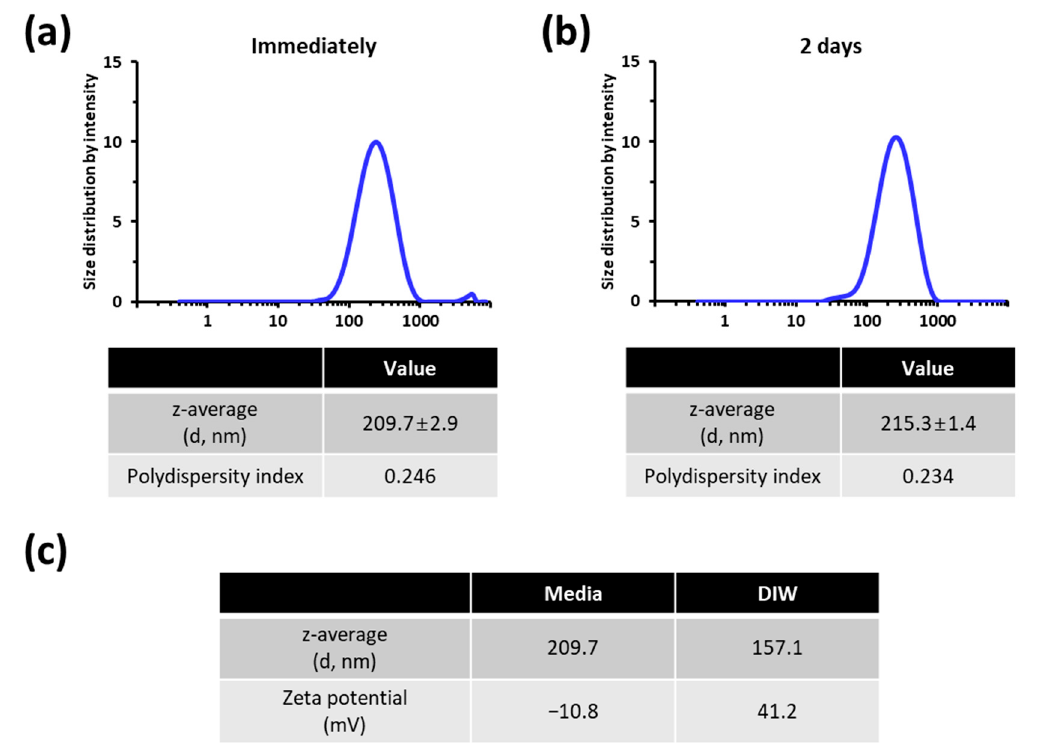
Figure 2. Characterization of TiO 2 NP dispersion in the cell growth media. TiO 2 NPs were dispersed at 1 mg/mL in DMEM. Size was measured by DLS immediately ( a ) and 2 days ( b ) after dispersion. ( c ) comparison TiO 2 NPs dispersions in DIW and media. Size and zeta potential were measured immediately following the dispersion procedure.